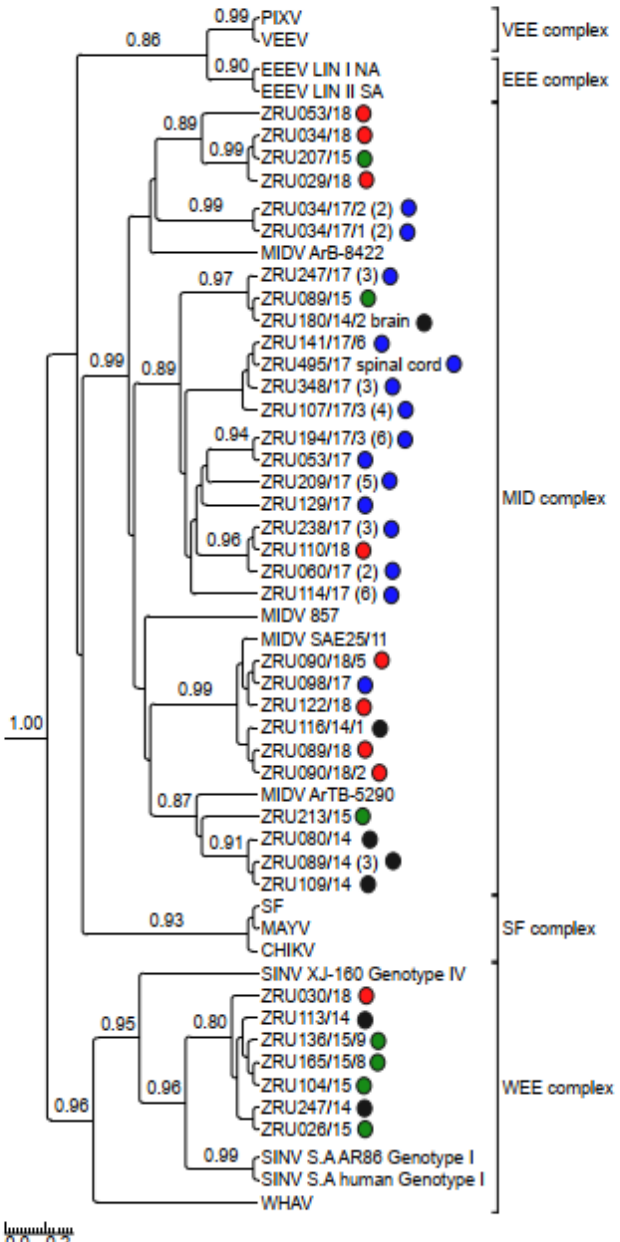
Figure 3. Rooted phylogenetic tree produced from Bayesian analysis using BEAST based on a 347- base pair nsP4 fragment (83 taxa, model GTR+G+I) of alphaviruses is shown. Posterior probabilities >0.7 are shown on major branches. Middelburg- and Sindbis virus positives described in current study indicated with ZRU numbers and circle colours correspond to year as follows: 2014 black, 2015 green, 2017 blue and 2018 red. All sequences obtained from whole blood or serum unless otherwise indicated. Number of sequences within the same clade for samples from the same year indicated in brackets. Alphavirus complexes indicated by brackets; tree is drawn to scale representing the number of nucleotide substitutions per site. CHIKV: Chikungunya virus; EEEV: Eastern equine encephalitis virus; MAYV: Mayaro virus; MIDV, Middelburg virus; PIXV: Pixuna virus; SFV, Semliki Forest virus; SINV: Sindbis virus; VEEV: Venezuelan equine encephalitis virus; WHAV: Whataroa virus; WEE: Western equine